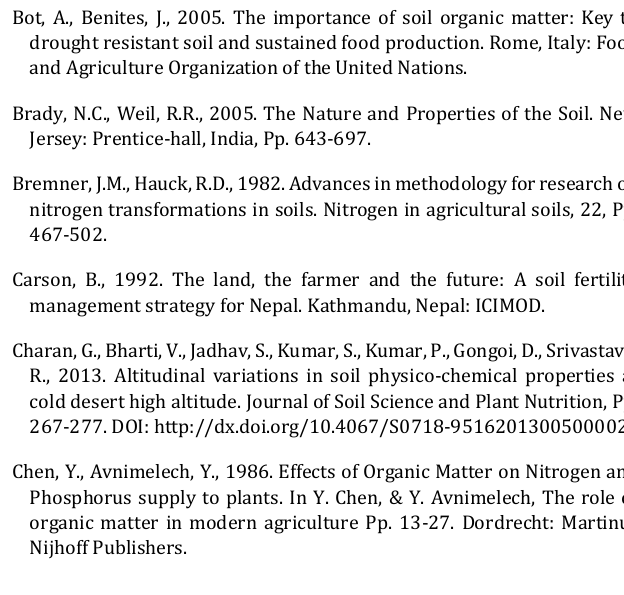
Figure 3: The relationship between available phosphorus and the soil pH